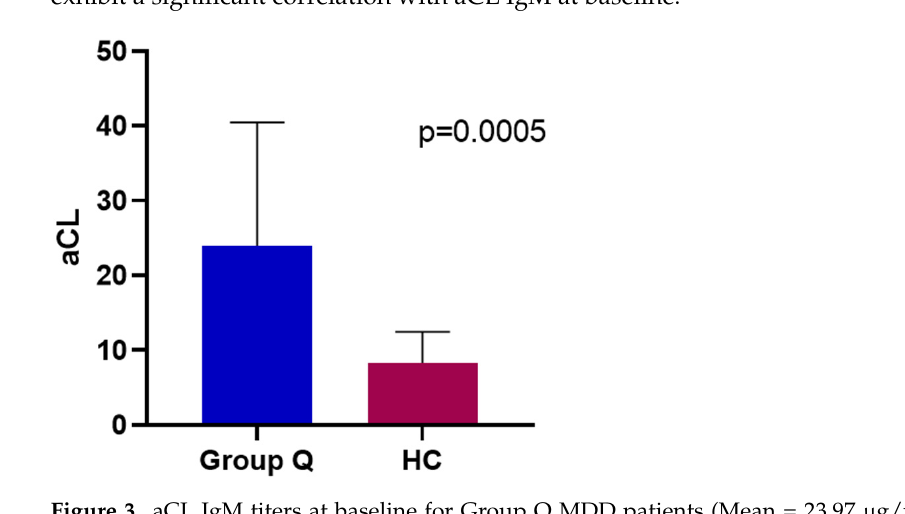
Figure 3. aCL IgM titers at baseline for Group Q MDD patients (Mean = 23.97 μ g/ml) and HC (Mean = 8.322 μ g/ml).